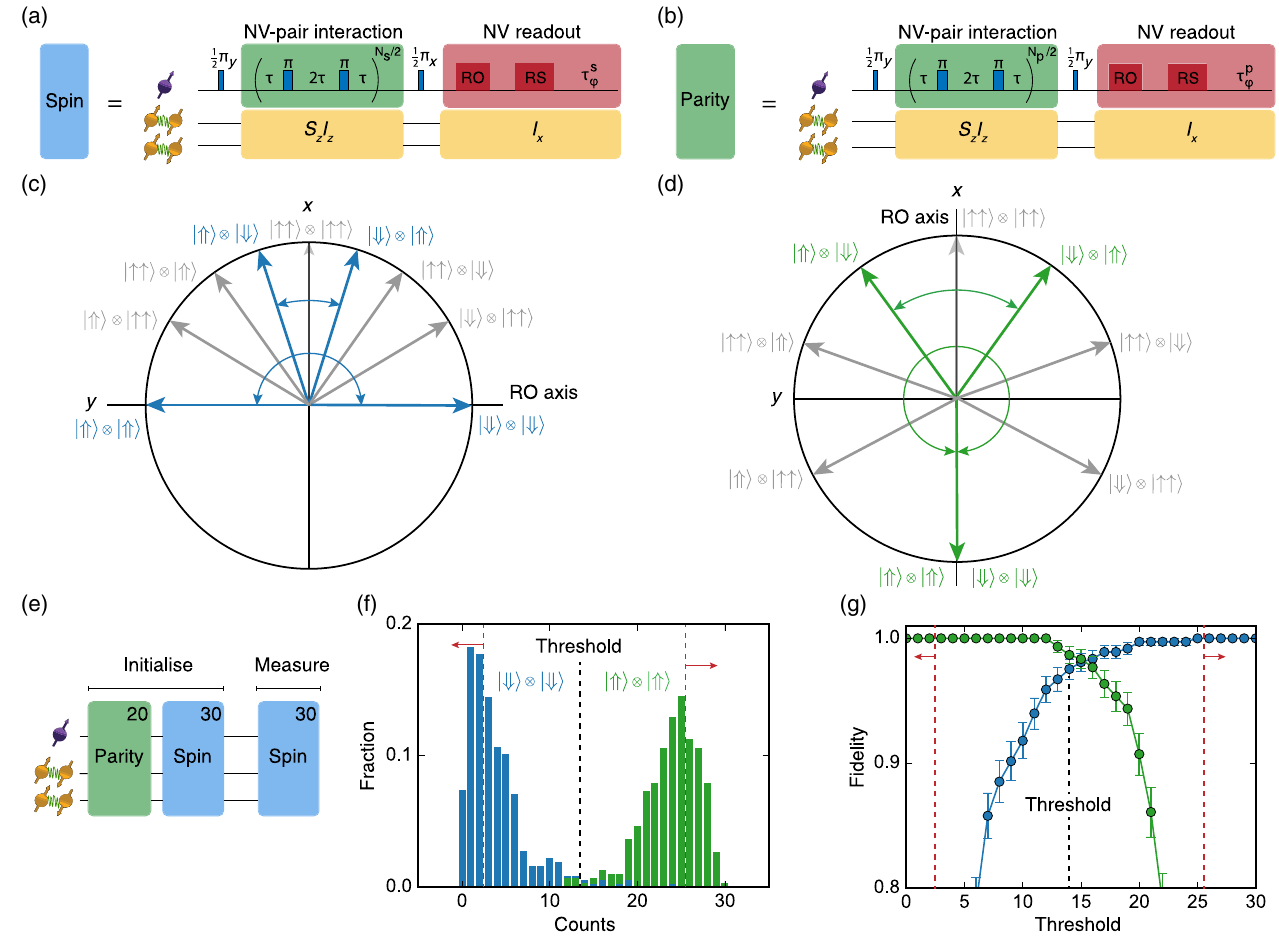
FIG. 2. Projective spin and parity measurements for pairs A and B . (a) Sequence to measure the pseudospin states. The NV electron ˆ S ˆ I τ ¼ 120 . 330 μ s and N 14 ) maps the state of the two pairs onto the NV spin. The spin starts in m s ¼ 0 . The z z interaction sequence ( s ¼ NV spin is subsequently read out (RO) and reset (RS) to m s ¼ 0 . We synchronize subsequent repetitions by calibrating a waiting time τ s 323 . 5 μ s to compensate for the ˆ I 1 =X . x evolution during NV readout. This ensures that the full sequence duration is a multiple of ϕ ¼ (b) Sequence to measure the pseudospin parity ( N p ¼ 20 , Supplemental Sec. IV [38]). We set τ p ϕ ¼ 81 μ s to synchronize subsequent measurements [sequence duration a multiple of 1 = ð 2 X Þ ]. (c) XY plane of the NV Bloch sphere showing the possible phases accumulated in the spin measurement. The NV spin starts along x and picks up a positive (negative) phase for a pair in j ⇑ i ( j ⇓ i ) and no phase for a pair in a parallel state ( j ↑↑ i or j ↓↓ i ). Reading out along the y axis distinguishes the four pseudospin states (blue). Note that j ↓↓ i (not shown) gives the same result as j ↑↑ i . (d) XY plane of the NV Bloch sphere under parity readout. The initial state ( x axis) and the readout axis ( x axis) are identical so that the parity of pairs A and B is measured. (e) Measurement sequence to calibrate single-shot readout and initialization. The top right of each block indicates the number of repetitions. The optimal number of spin readouts is 30 (Supplemental Sec. III [38]). (f) Conditional histograms for 30 spin readouts after initialization in j ⇑ ij ⇑ i (green) and j ⇓ ij ⇓ i (blue). The initialization conditions for the 30 preceding spin readouts are indicated in red. (g) Combined initialization and readout fidelity for j ⇑ ij ⇑ i (green) and j ⇓ ij ⇓ i (blue) for 30 spin readouts. We find an optimum of F ¼ 98 . 1 ð 5 Þ % for a decision threshold of 14 out of 30. The error bars represent one standard